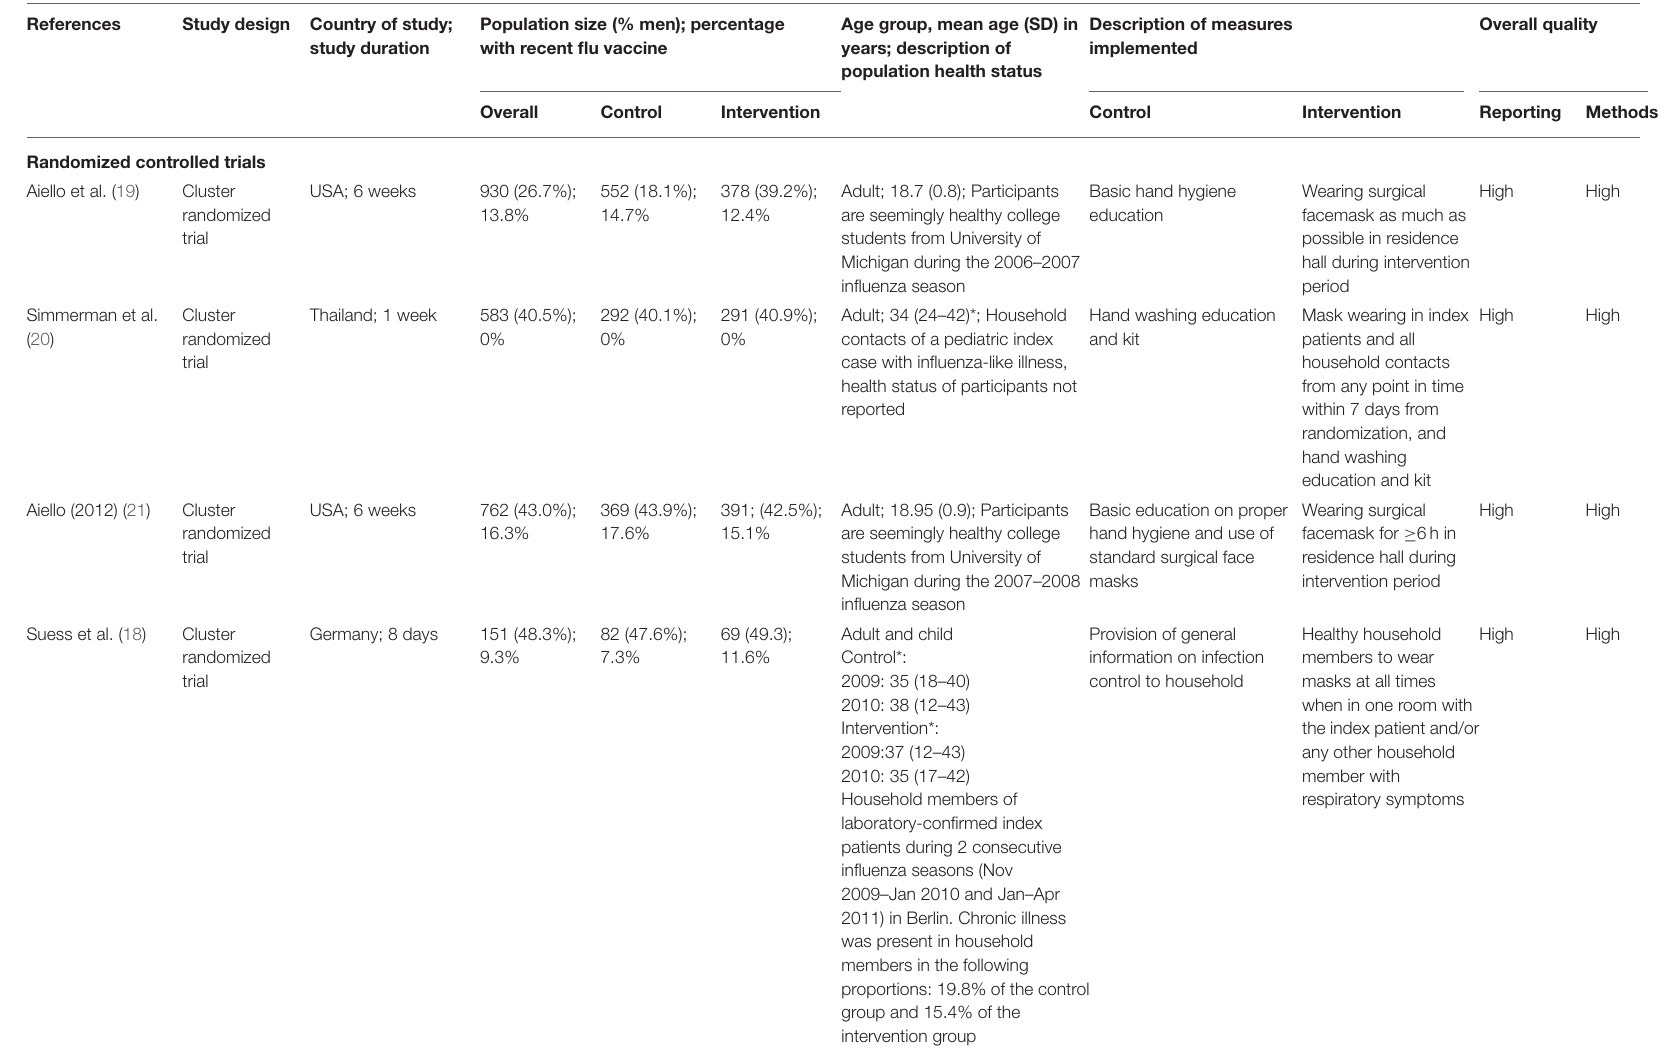
TABLE 1 | Characteristics of included